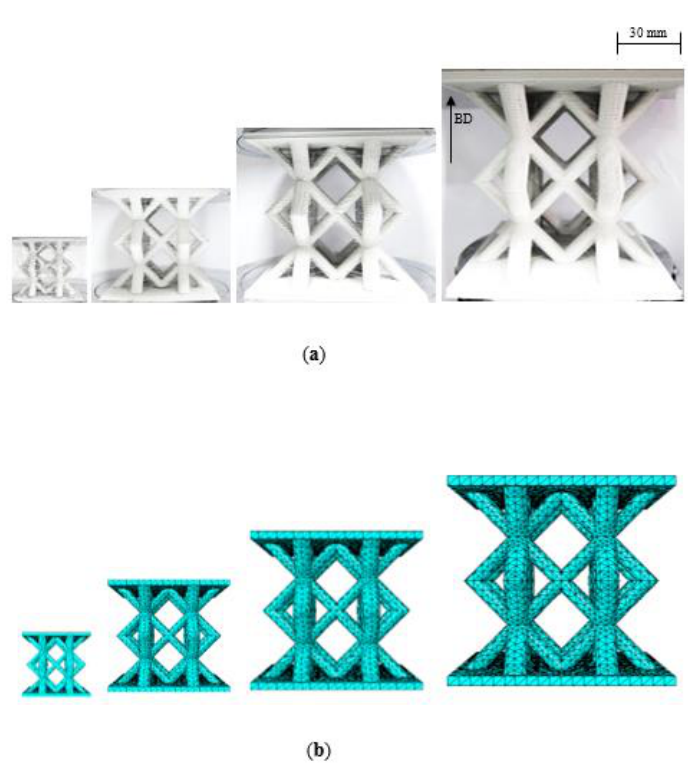
Figure 3. ( a ) Photographs of the four scaled lattice samples where the build direction (BD) is indicated by an arrow. ( b ) Finite element models of the four scaled sizes lattice structures.